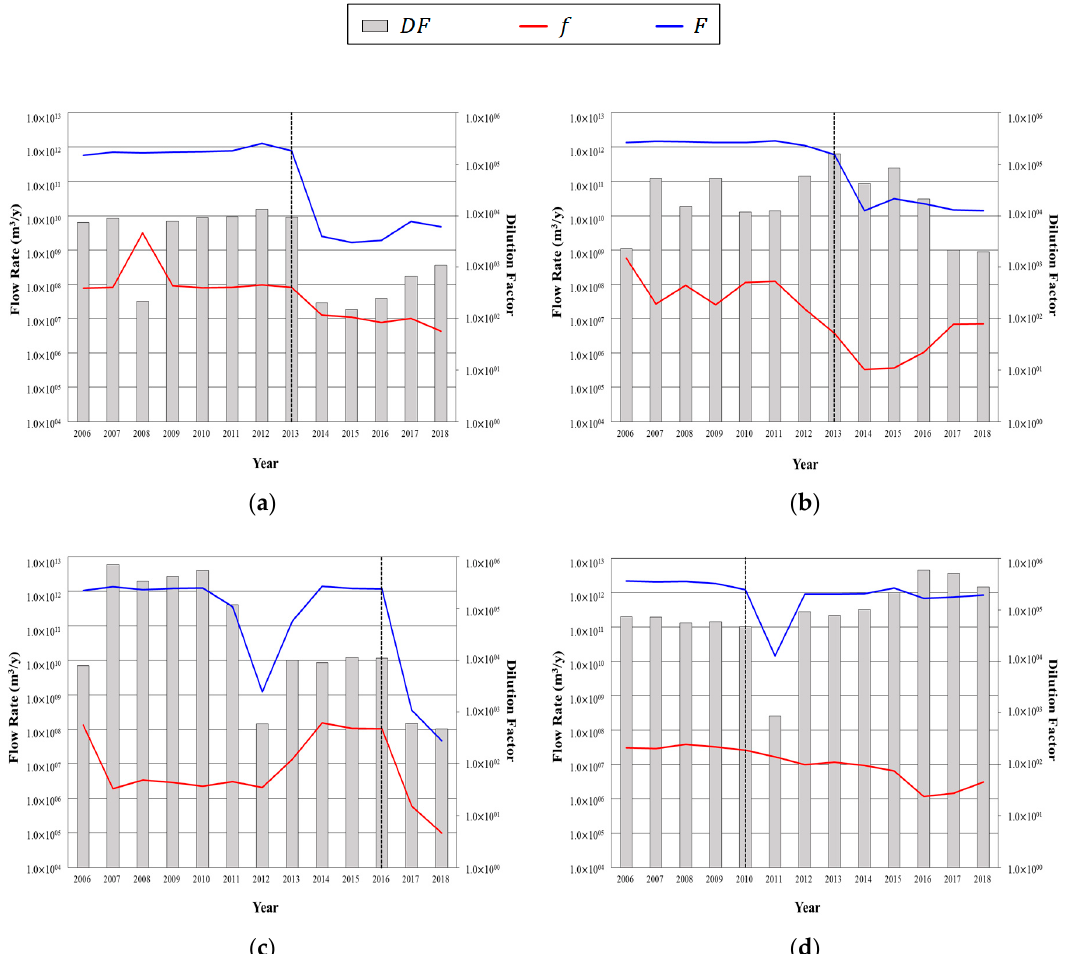
Figure 7. Annual variations of discharge conditions (i.e., f , F , and DF ) of liquid e ffl uent from NPPs as: ( a ) Kewaunee; ( b ) San Onofre-2 and 3; ( c ) Fort Calhoun; ( d ) Crystal River-3. The dotted line indicates the year of permanent shutdown.